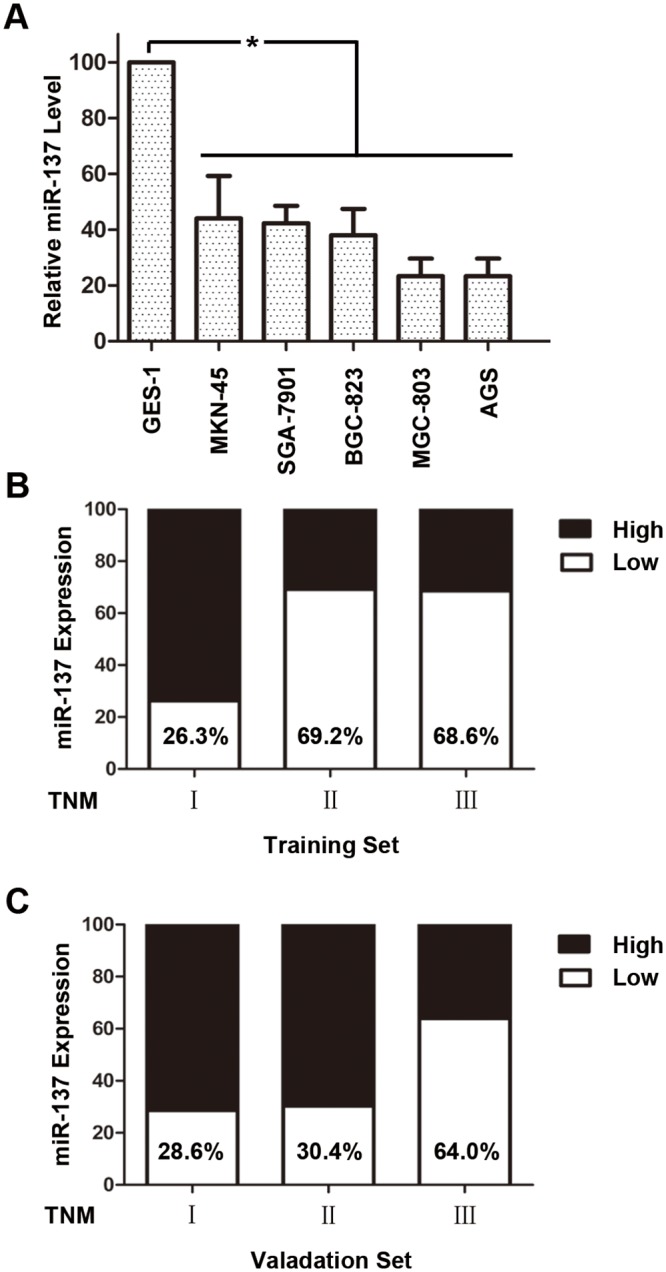
The expression of miR-137 in human gastric cells and tissues.(A) qRT-PCR analysis for miR-137 expression levels in immortalized normal human gastric epithelial cell line GES-1 and five human gastric cancer cell lines (MKN-45, SGC7901, BGC-823, MGC-803, and AGS). (B-C) The percent of patients with low miR-137 expression increased accompanied with disease progression from TNM stage I to III in (B) Training set (n = 67) and (C) Validation set (n = 87). *P<0.05.